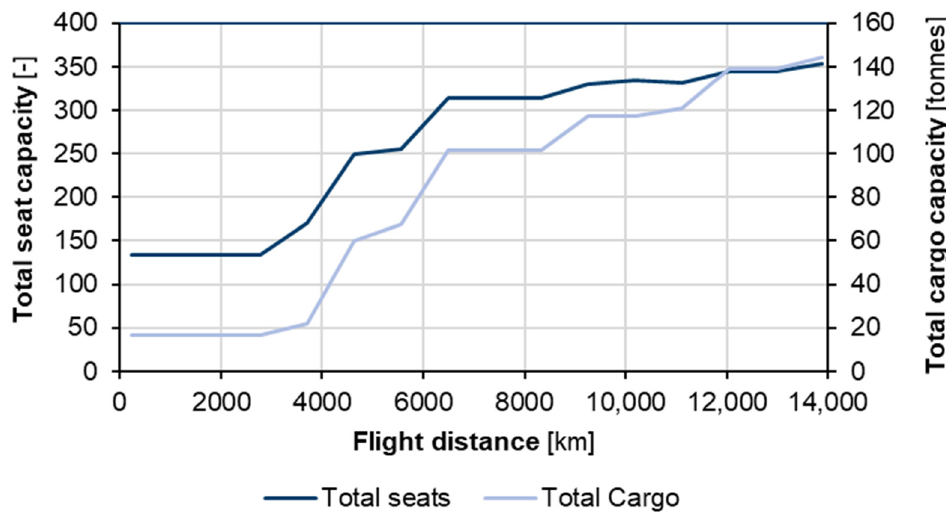
Figure 7. Seating and cargo capacity as a function of the flight distance.